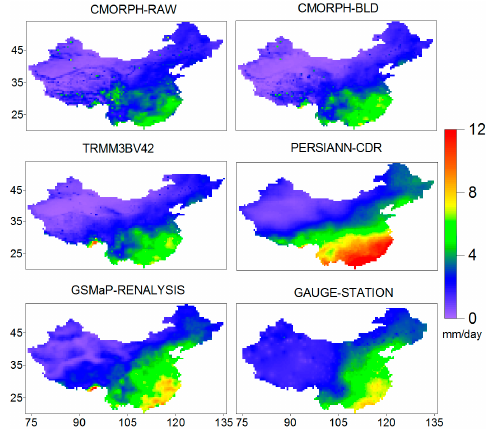
Figure 2. Spatial features of the nine-year mean daily rainfall obtained from CMOPRH_BLD,